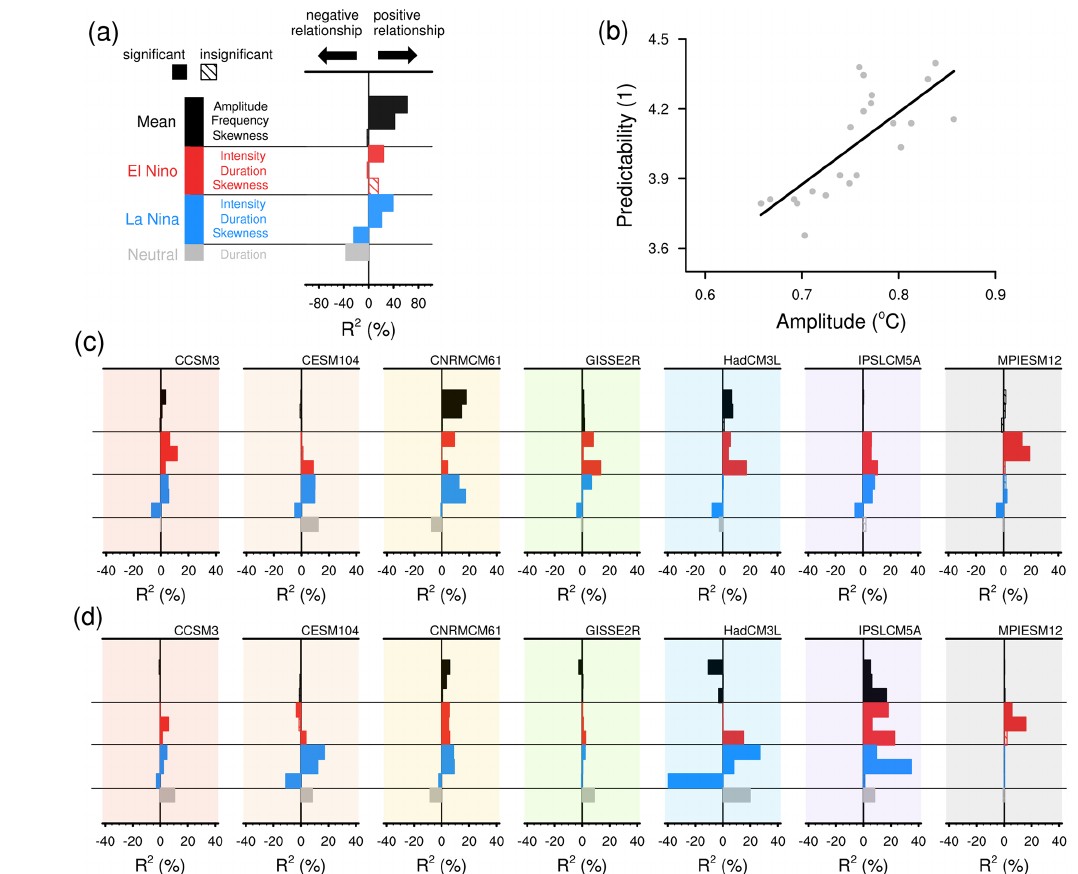
Figure 8. (a) R 2 values in the observations, which are calculated from regression analyses between 10 ENSO metrics and predictability as shown in the label bar. (b) Example plot of the regression analysis that represents the uppermost bar in (a) . The small gray dots are 30-year chunks from the time series, and the line shows the regression slope. (c) Similar to (a) but for the control. (d) Similar to (a) and (c) with regression analyses between changes in ENSO characteristics and predictability. The sign of the bars represents the sign of the regression slopes. The solid (hatched) bars represent regression slopes that significantly (insignificantly) differ from